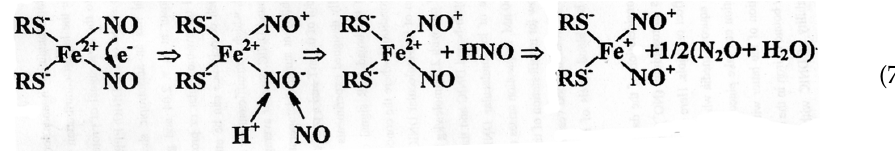
Blocking of nitrosonium cation hydrolysis in DNICS with thiol-containing ligands prevents their release from these complexes, due to which the latter cannot be